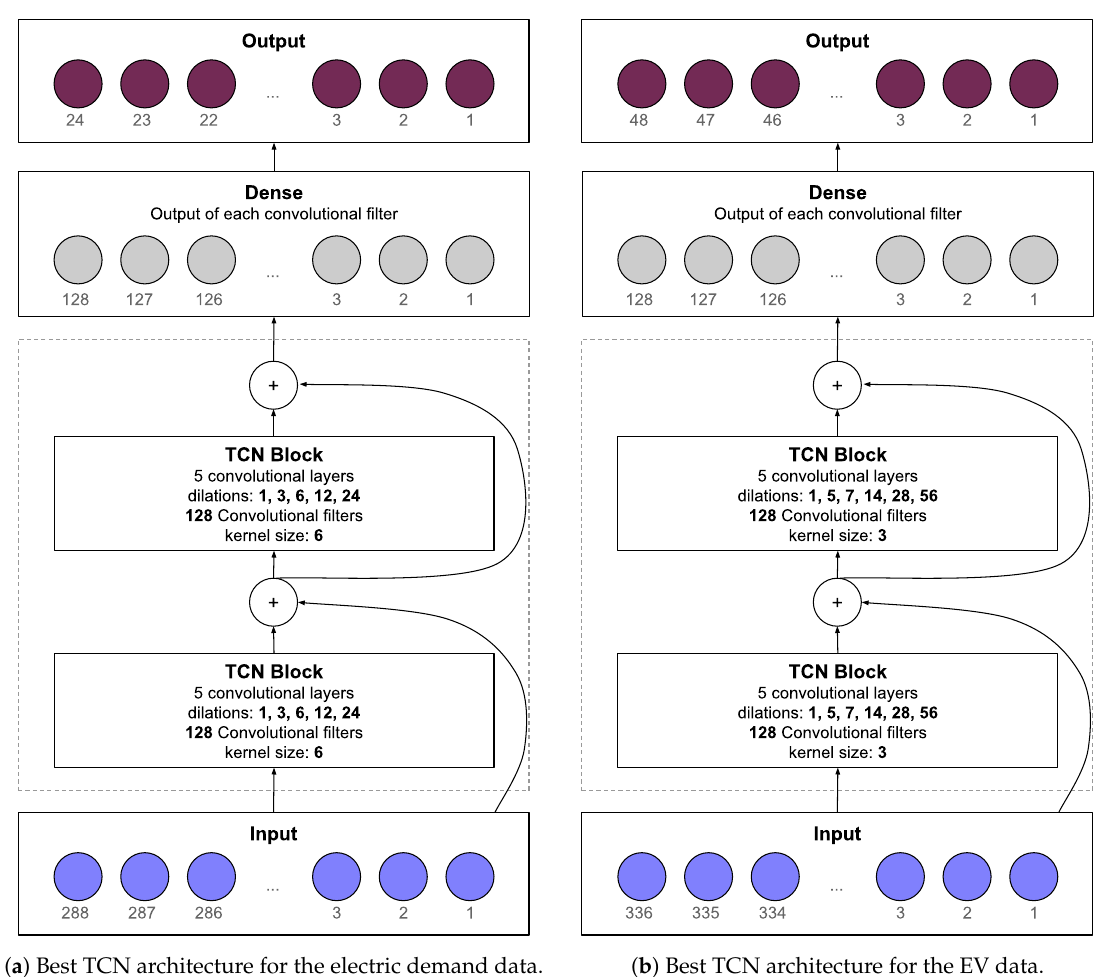
Figure 7. Architecture of the best TCN model for each